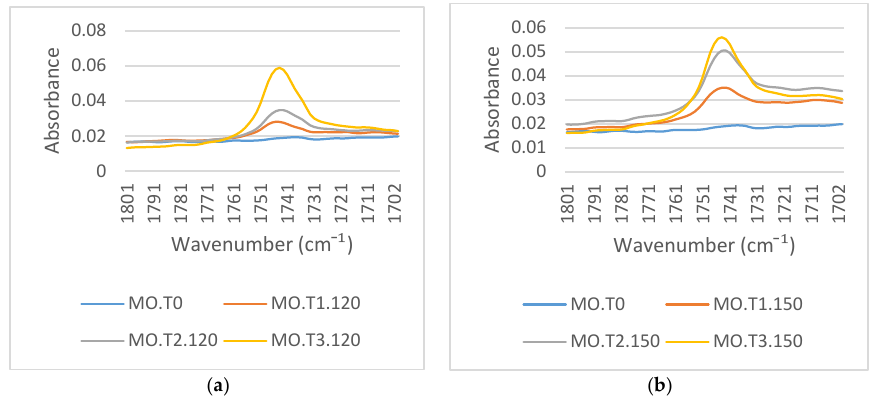
Figure 7. FTIR spectra at 1800–1700 cm − 1 of transformer paper aged in mineral oil at aging temperatures of ( a ) 120 °C and ( b ) 150 °C.